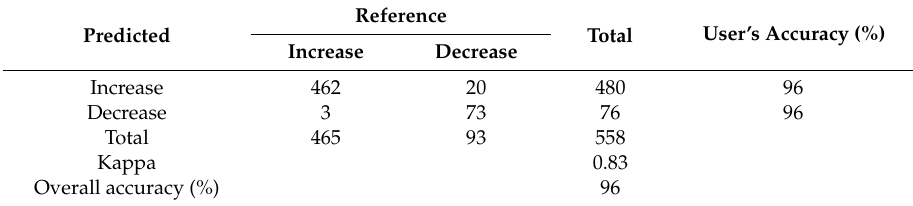
Table 5. Aggregated confusion matrix of dominant height change classifications for the four